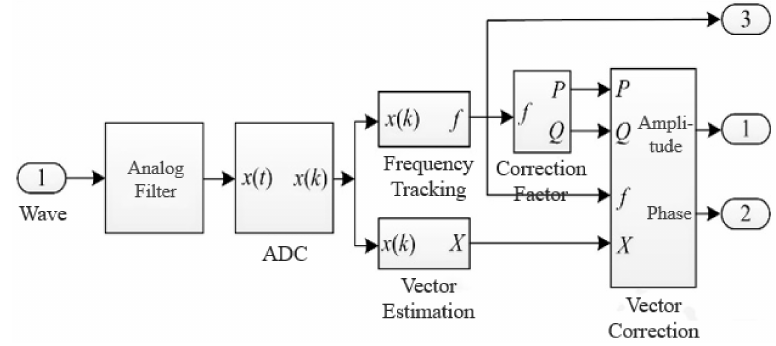
Figure 10. Internal structure of the phasor measurement